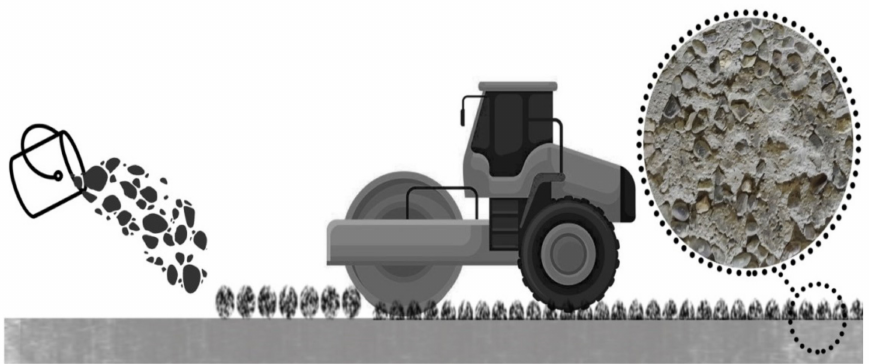
Figure 3. Steps of the seeding macro-texture (the right picture is author-originated).